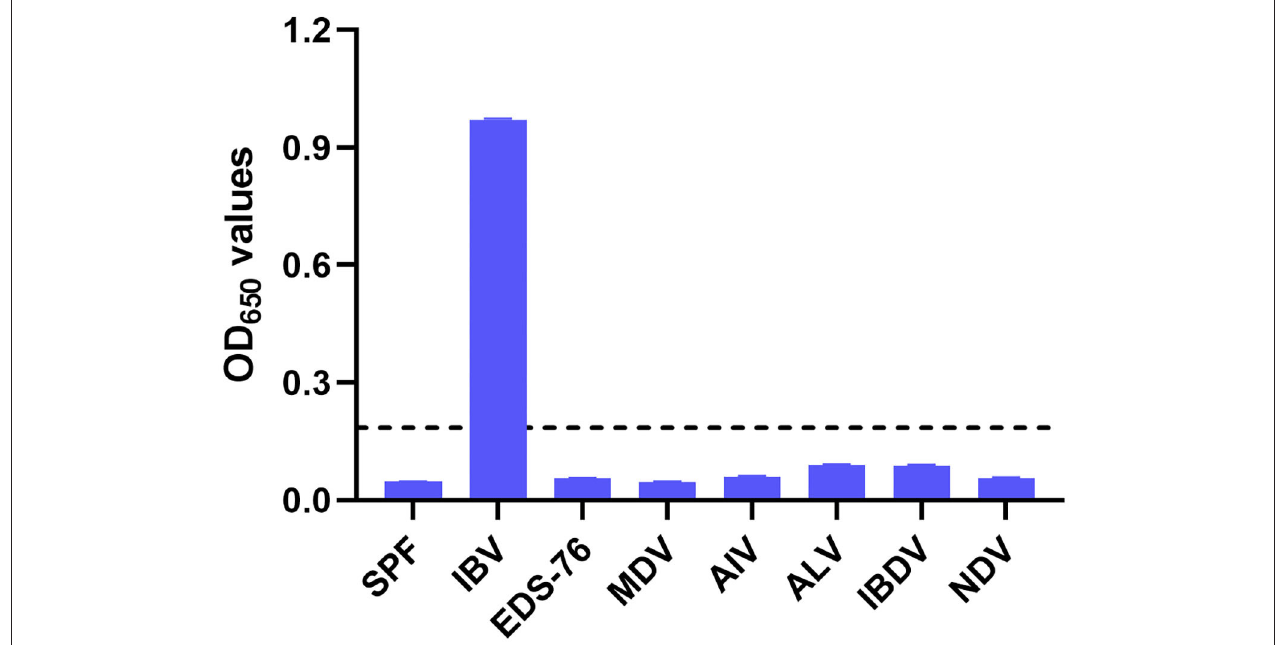
FIGURE 2 | Specificity of the pELISA. Specificity of the pELISA in detecting antibodies against common chicken viruses. Antisera raised against Newcastle disease virus (NDV), avian influenza virus (AIV, H9N2), avian leukosis virus (ALV), Marek’s disease virus (MDV), egg drop syndrome virus (EDS-76V), and infectious bursal disease virus (IBDV) were tested by pELISA. Their OD 650 values were lower than the cutoff value. The black horizontal dotted line indicates the cutoff.